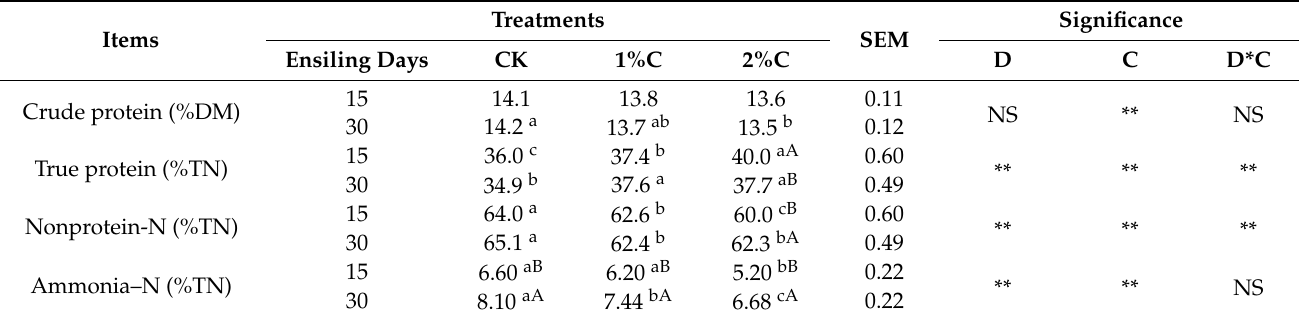
Table 3. Effect of mixing biochar on the protein fractions of alfalfa ensiled for 15 and 30